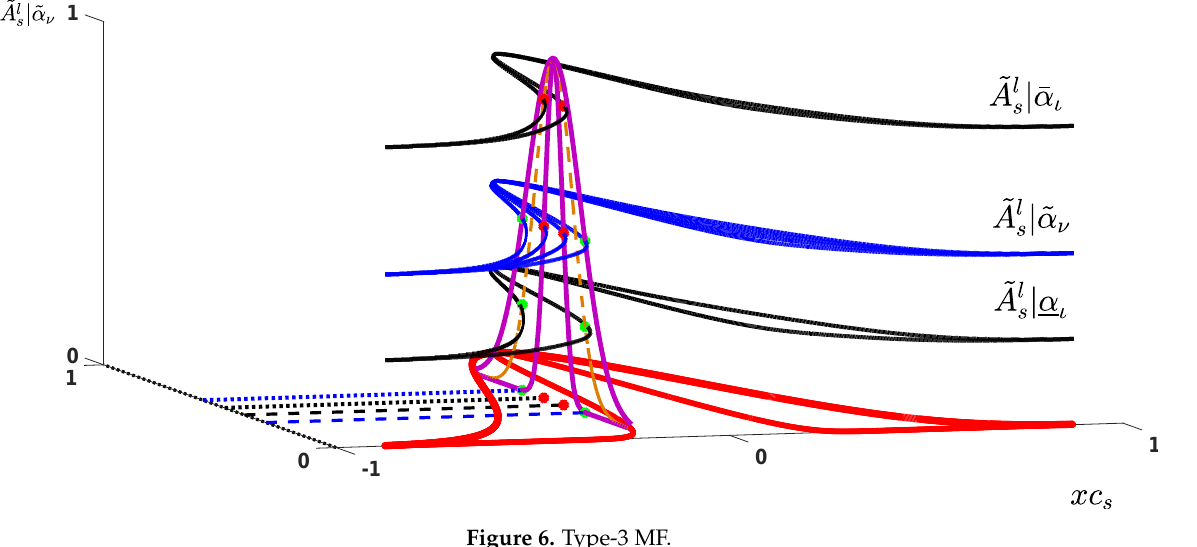
Figure 6. Type-3